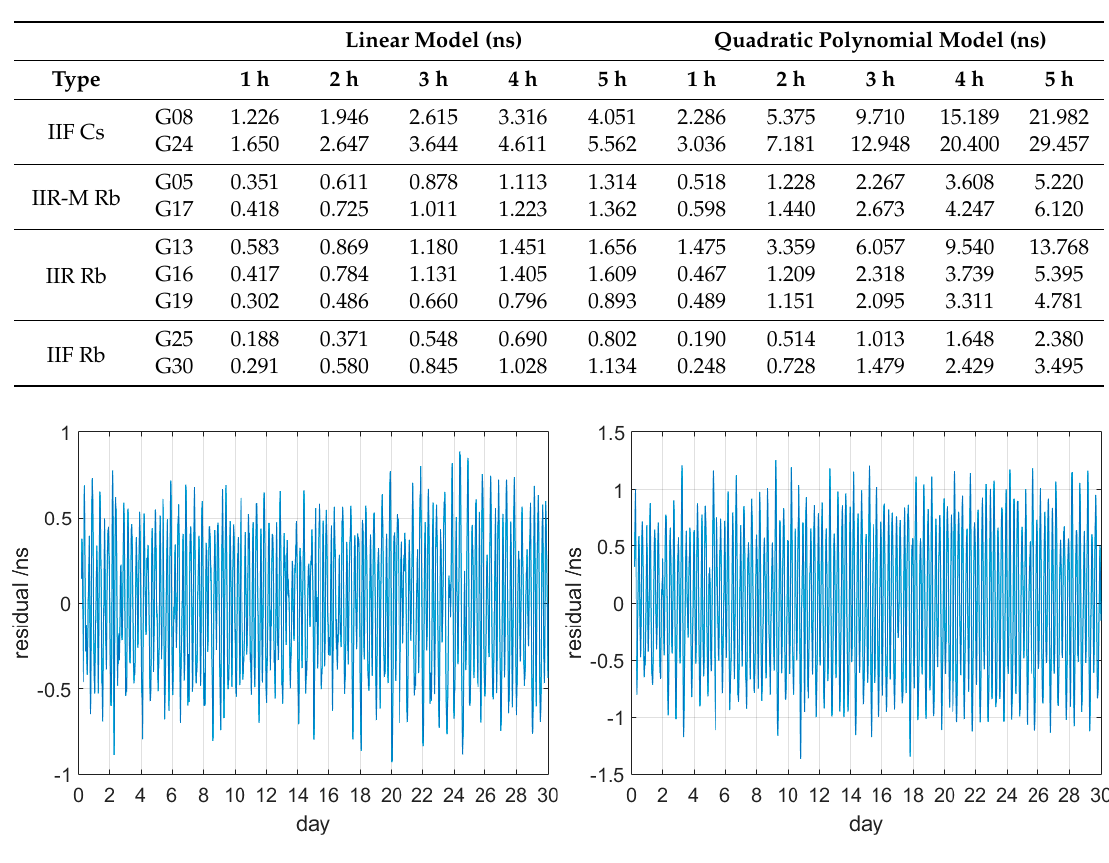
Table 3 . Performance of linear and quadratic polynomial models.